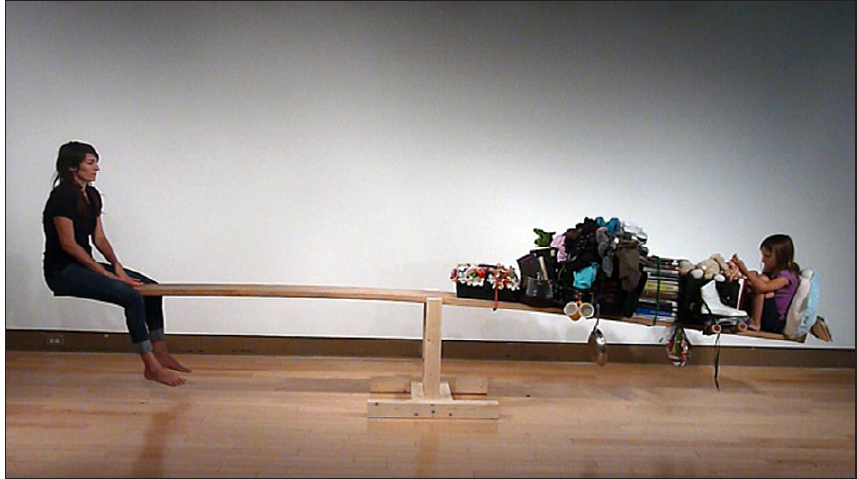
Figure 19: Courtney Kessel, In Balance With, performance, 30 – minutes, 2009 –